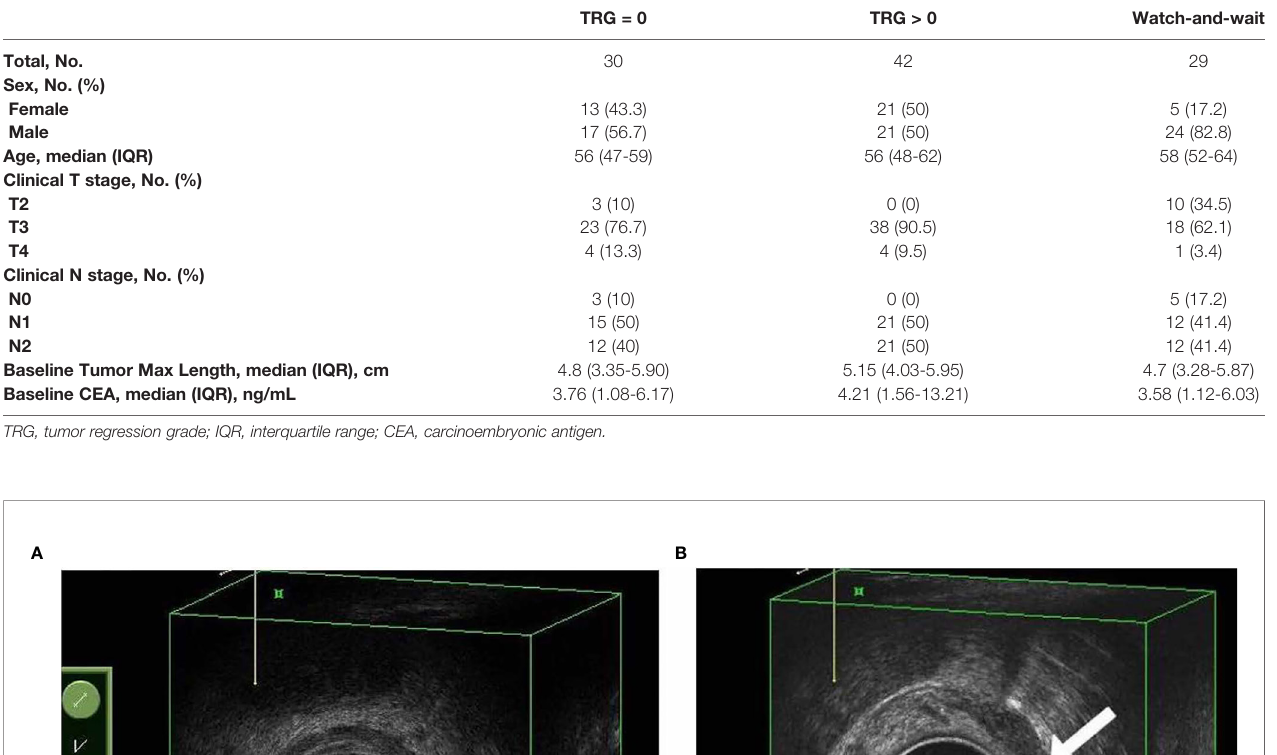
TABLE 2 | Baseline characteristics of the patients with TRG = 0, TRG > 0, and watch-and-wait group. Total,